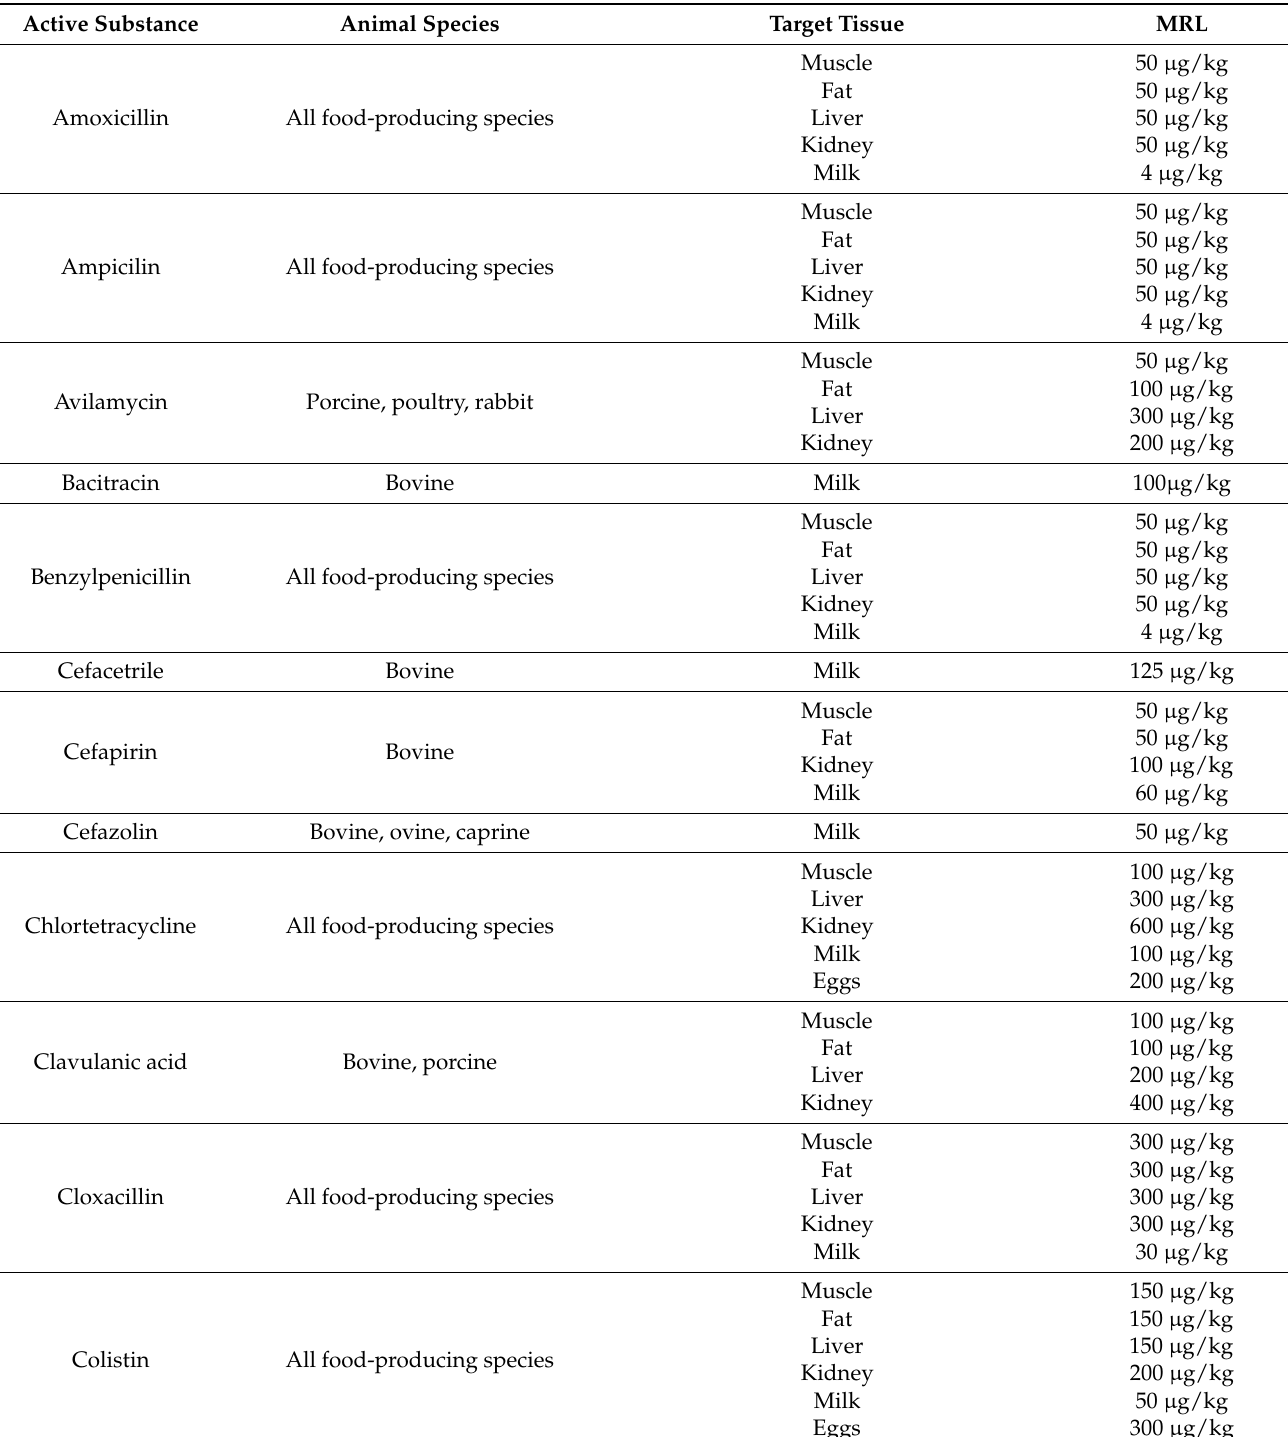
Table 4. Maximum residues limits of antibiotic in products of animal origin marketed in the European Community